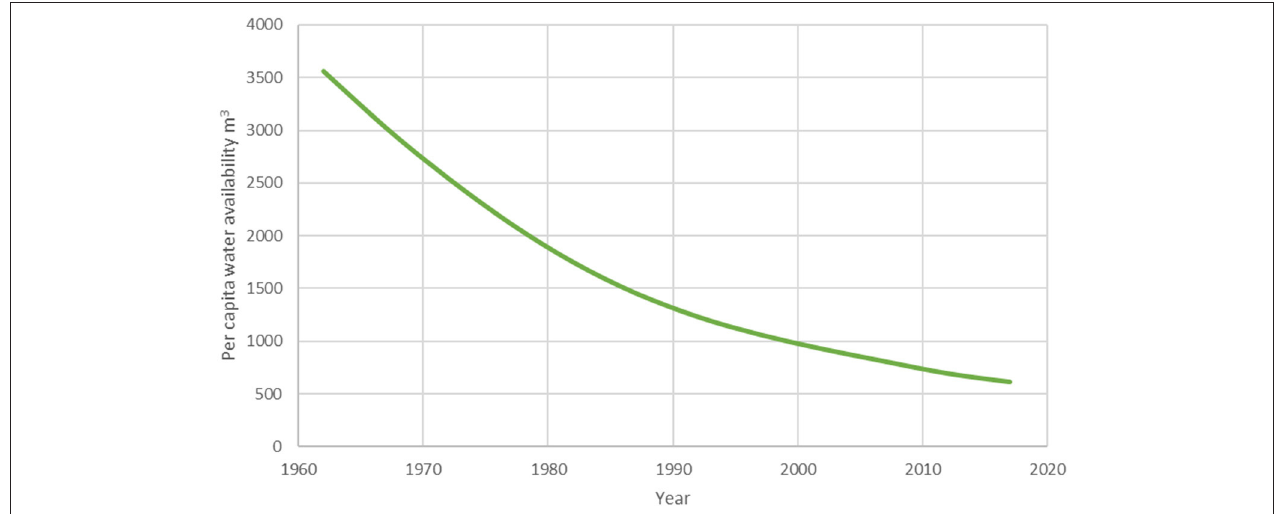
FIGURE 3 | Declining in per capita water availability in Kenya (FAO,